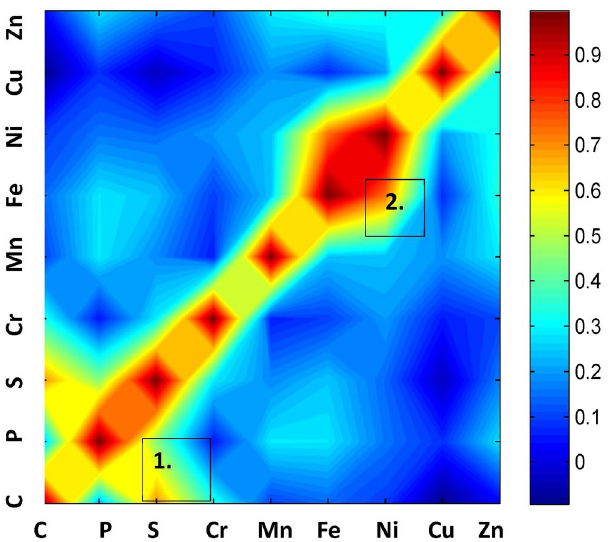
Figure 6. : 2D correlation analysis of the abundance of elements ( 13 C, 31 P, 34 S, 52 Cr, 55 Mn, 56 Fe, 58 Ni, 63 Cu and 64 Zn) in the 6 breast tissue